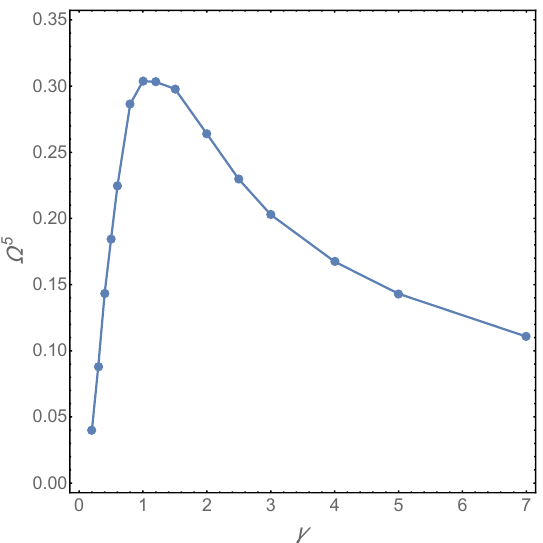
Figure 8 . Volume of 5D positive region Ω (5) with different γ for x = 1 . The maximum of Ω (5) is at γ = 1